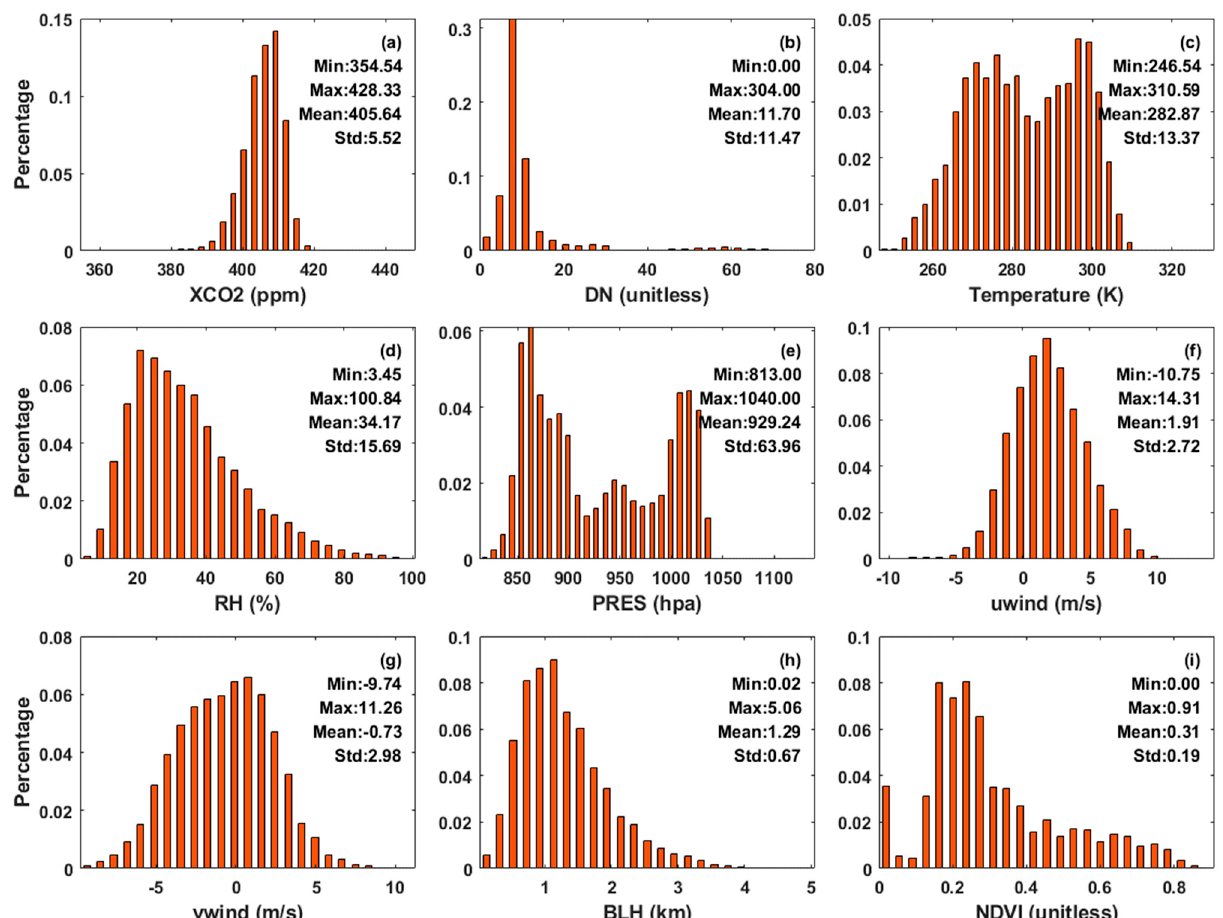
Figure 5. The frequency histogram of parameters in XCO 2 concentration modeling (n = 62,964). ( a – i ) represent CO 2 column concentration, digital number, temperature, relative humidity, pressure, vertical wind speed, horizontal wind speed, boundary layer height, and normalized vegetation index, respectively.